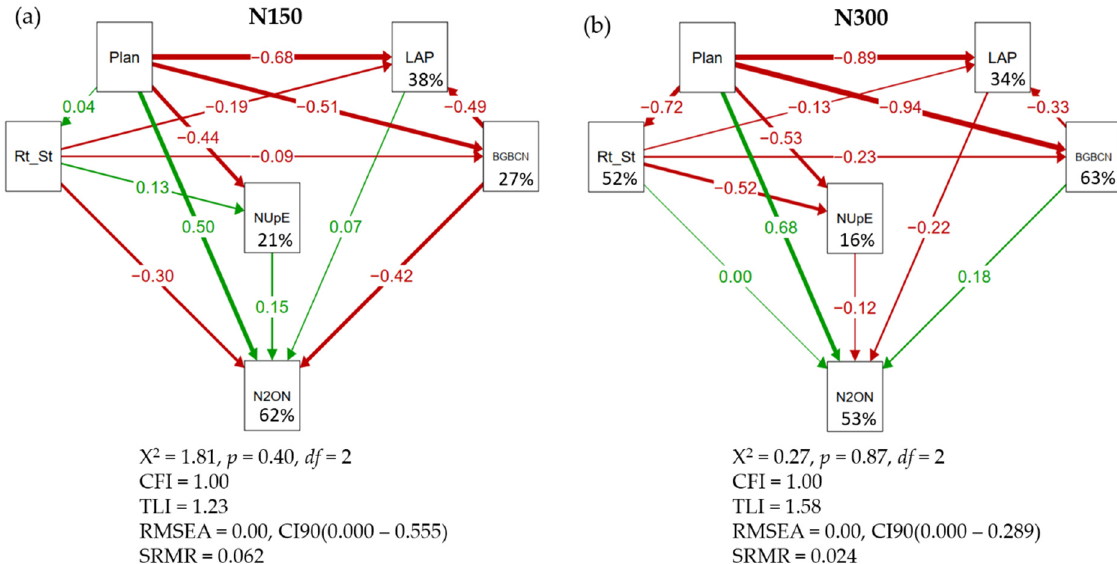
Figure 5. Structural equation models showing the relationships between the measured variables at ( A ) the N150 fertilizer rate and ( B ) at the N300 fertilizer rate. Plan–forage plantain proportion; NUpE—whole plant N uptake; Rt_St—root/shoot ratio; BGBCN—belowground biomass C/N ratio; LAP—leucine aminopeptidase, a proxy for microbial activity; green arrows represent a positive association, and red arrows represent a negative association; numbers within arrows represent standardized path coefficients, whereby negative path coefficients indicate a negative relationship. The higher the absolute value of the path coefficient, the more important is the path. Numbers in the white boxes show the percentage of explained variance of each of the endogenous variables. Χ 2 indicates the fit of the model, Comparative Fit Index (CFI), Tucker Lewis Index (TLI), and the Root Mean Square Error of Approximation (RMSEA). Table 4. Linear effect of the measured biomass traits on N 2 O emissions.